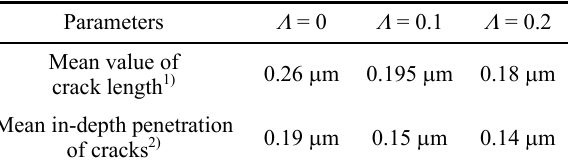
Table 2 Parameters of >0.05  m length subsurface cracks in the model samples of